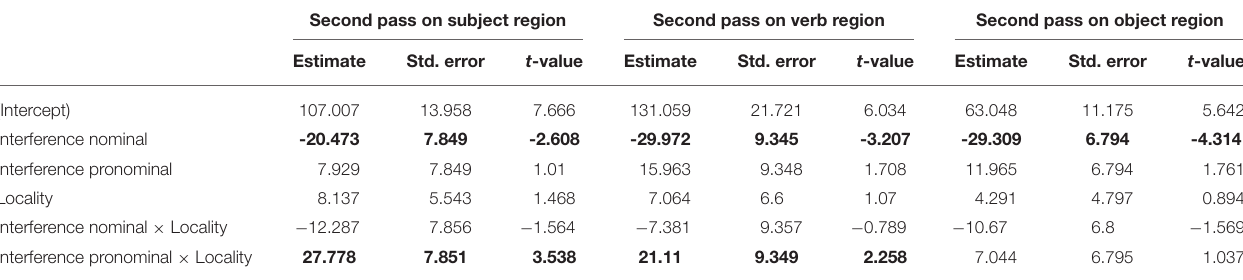
TABLE 8 | Experiment 2: nominal advantage in second pass re-reading times.